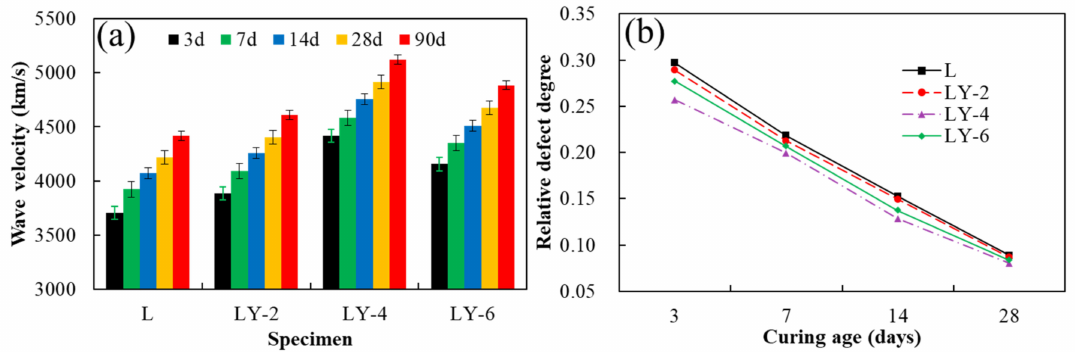
Figure 6. Ultrasonic non-destructive test results: ( a ) wave velocity, ( b ) relative defect